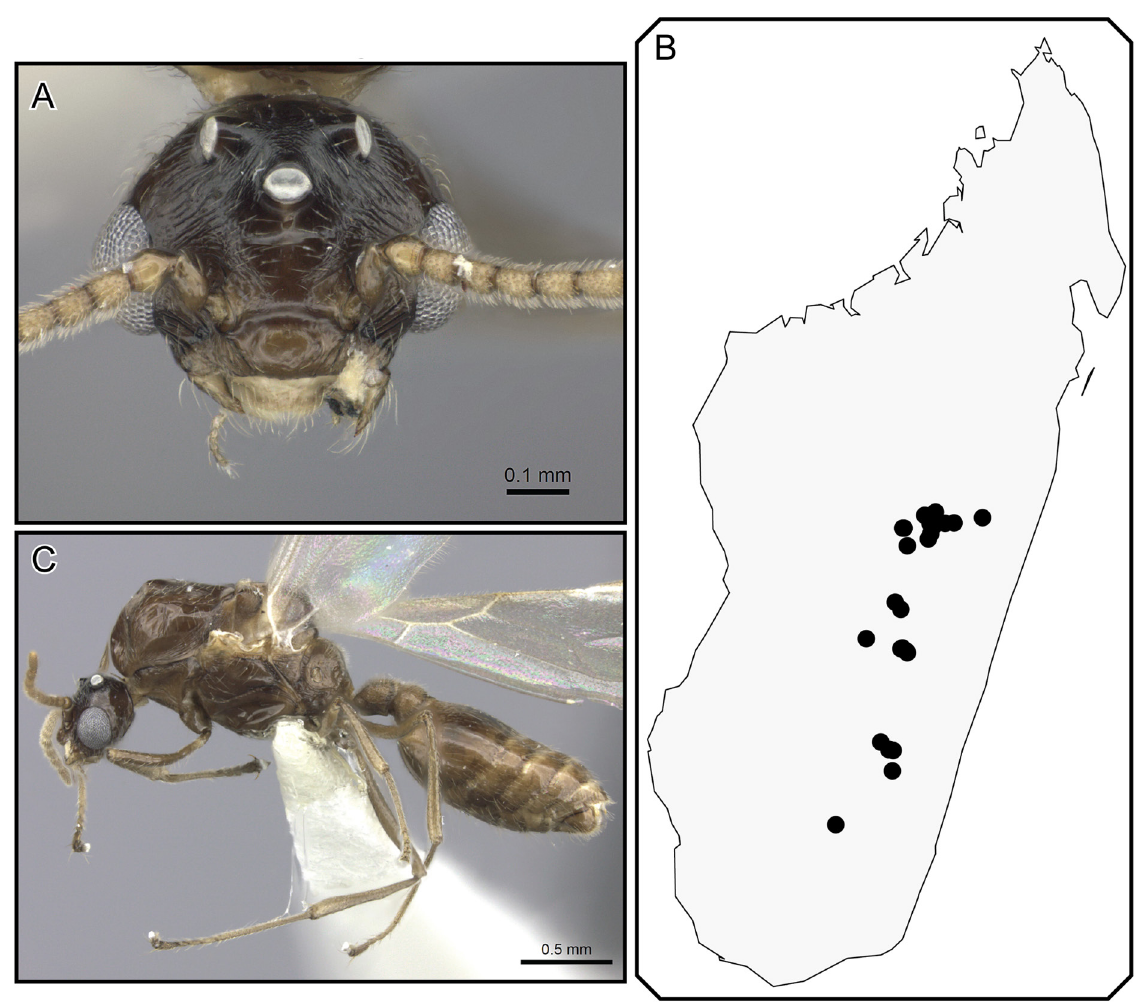
Fig. 9. Crematogaster degeeri Forel, 1886, male and distribution. A, C. (CASENT0127520). A. Full- face. C. Profile. B. Species